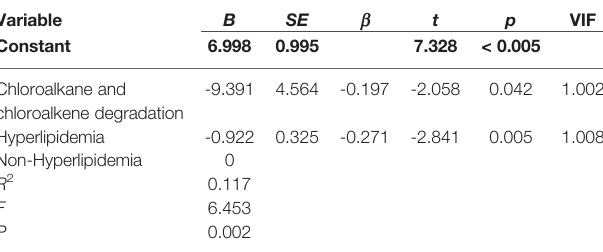
TABLE 4 | Linear regression analysis for chloroalkane and chloroalkene degradation predicting FLC l